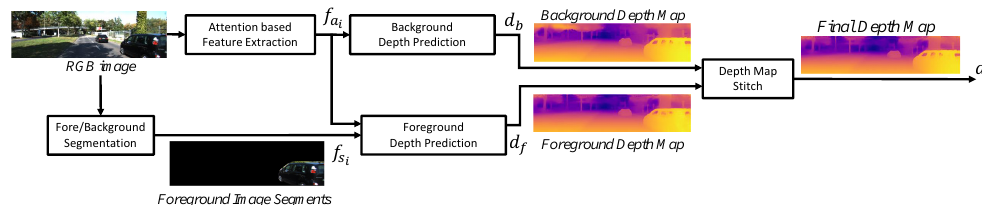
Figure 2. The architecture of our proposed